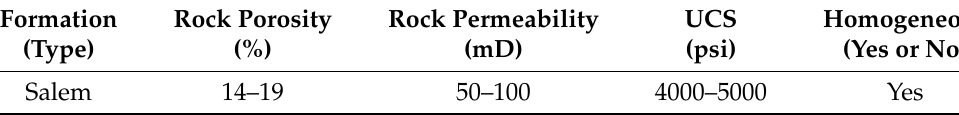
Table 1. Properties of the rock as received from the company